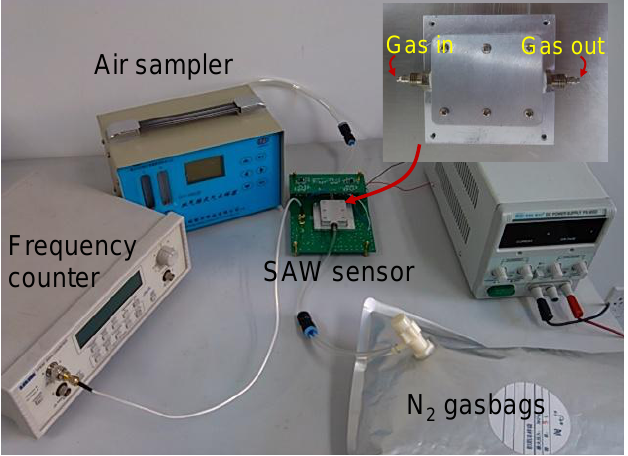
Figure 6. The experimental setup of the SAW humidity